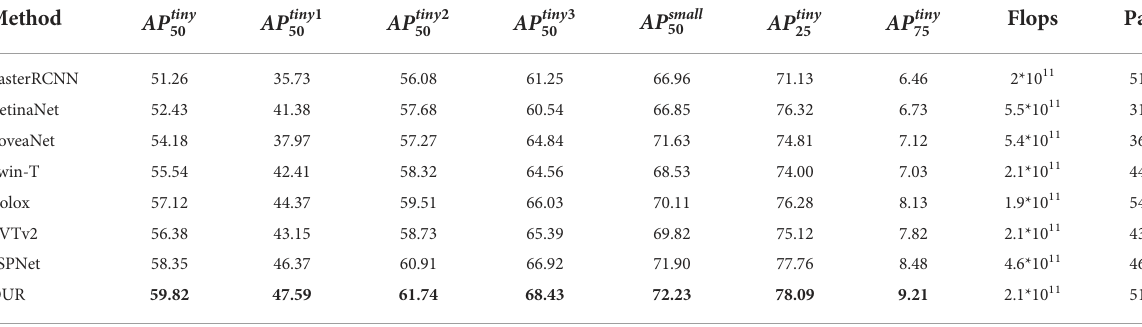
Bold values indicates the best detection result in each column. TABLE 5 Comparison of different methods on WSODD.